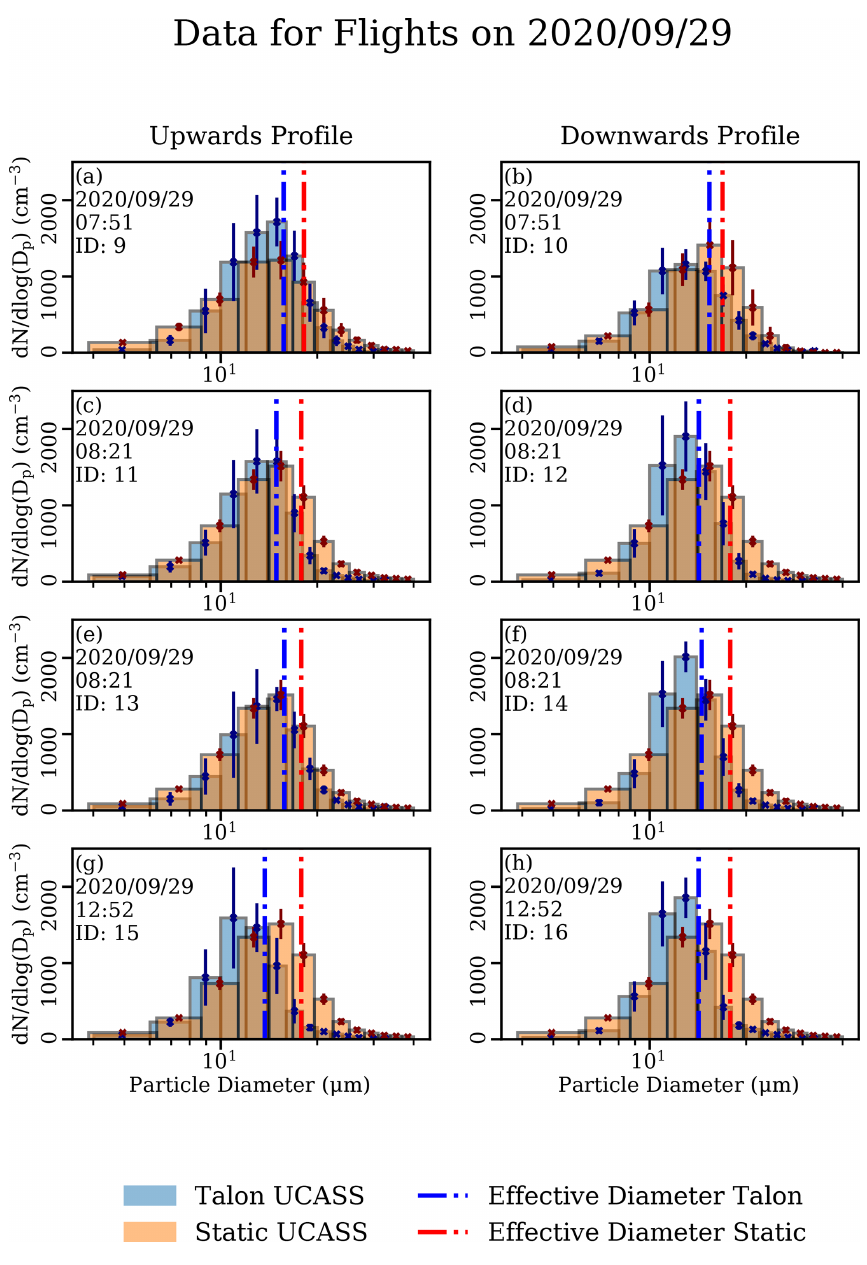
Figure 10. Plots of d N/ dlog (D p ) plotted against droplet diameter for the flights conducted on 28 September 2020. The column of plots (a, c, e, g) is the data taken on the ascent, and the column of plots (b, d, f, h) is that taken on the descent. The thickness of each bar is a UCASS bin, the orange bars are the static UCASS data, and the blue bars are the FMI-Talon – UCASS data. The dashed red line is the effective diameter for the Static UCASS data, and the dashed blue line is that of the FMI-Talon – UCASS data. The profile ID stated is consistent with Table